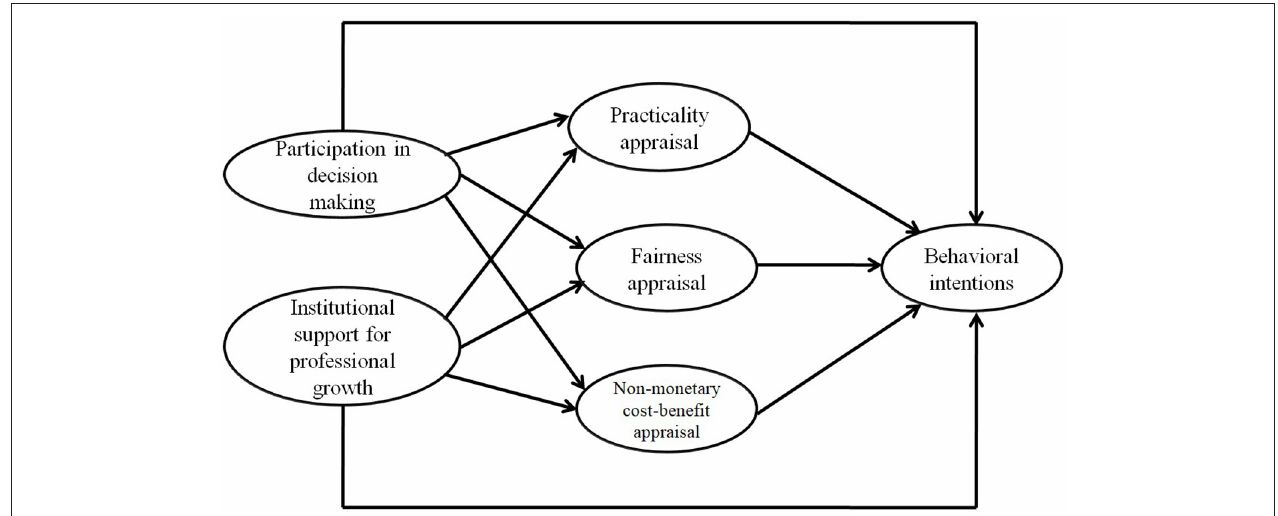
FIGURE 3 | Research framework and variables.